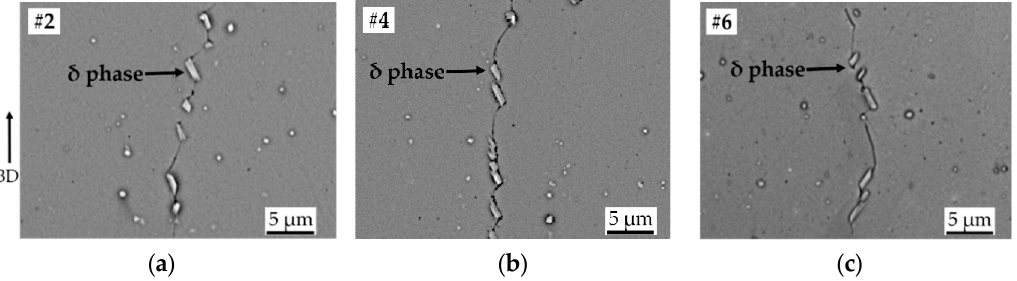
Figure 5. SEM micrographs of HIP1 + STA samples ( a ) LS = 125 µm, ( b ) LS = 225 µm, and ( c ) LS = 325 µm showing similar distribution of the δ phase. The arrow indicates the build direction.